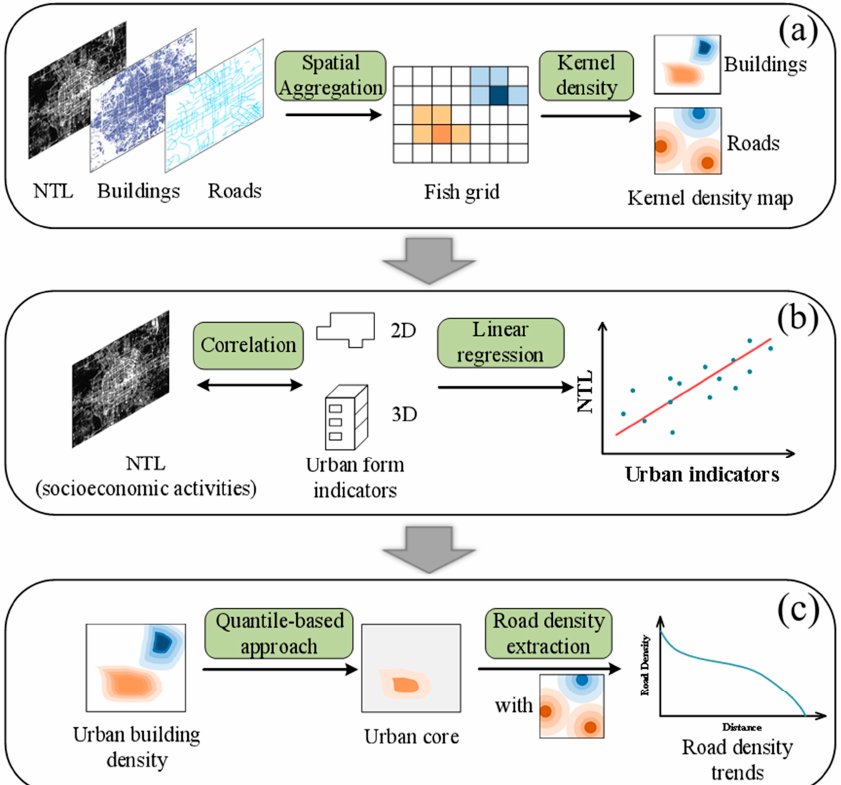
Figure 2. The proposed workflow in this study. ( a ) data preprocess; ( b ) correlation analysis between 2D/3D urban forms and nighttime light; ( c ) the relationship between building height and road den- sity.